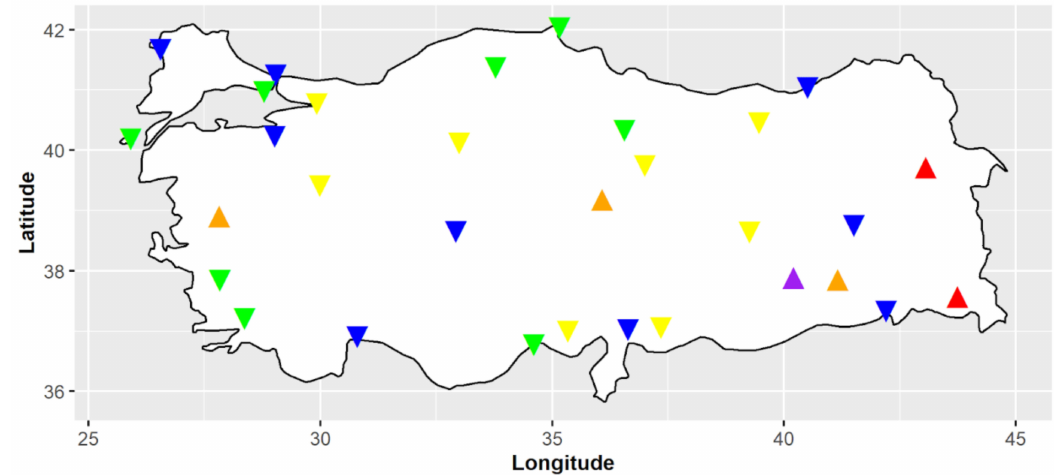
Figure A20. Same as Figure A13 but for July (See Figure A13 for legend).